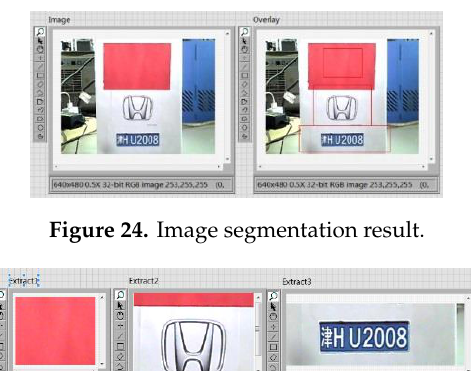
Figure 23. Program block diagram of image segmentation and extraction.